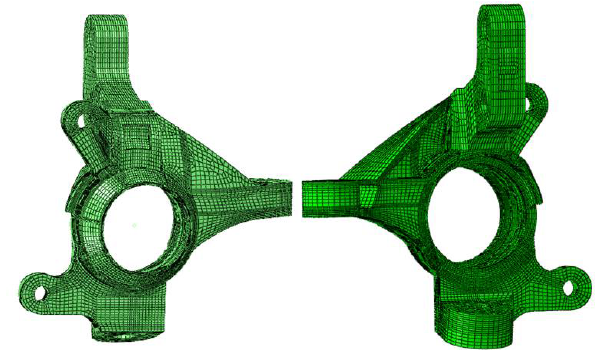
Figure 7. Finite element model of knuckle.